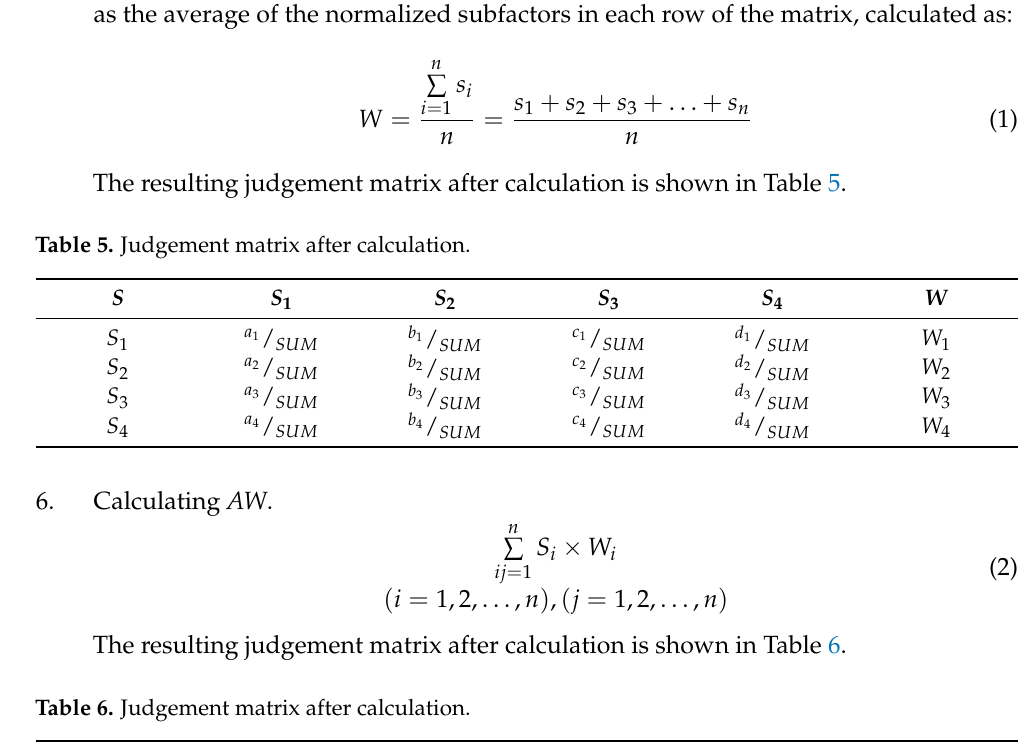
4. Calculate the eigenvectors W (or weights, relative importance) for each subfactor. 5. The eigenvector W of each row of the above established judgment matrix is calculated